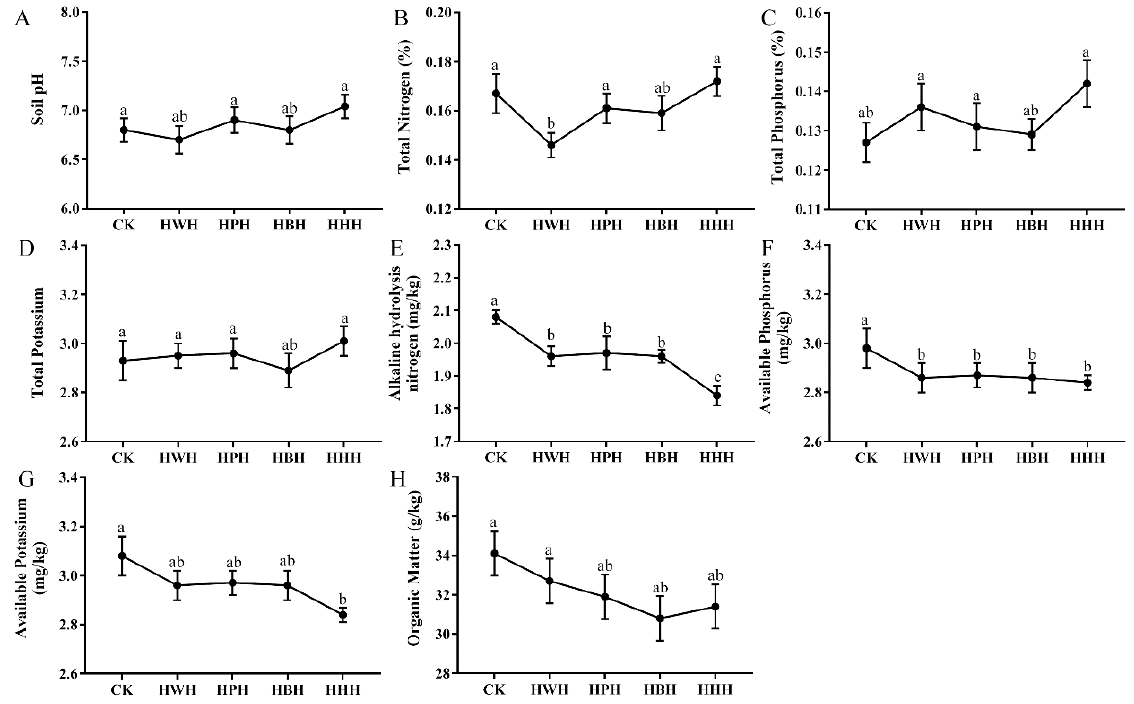
Figure 2. Effects of soil physicochemical properties. ( A ) Soil pH. ( B ) Total nitrogen for soil. ( C ) Total phosphorus for soil. ( D ) Total potassium for soil. ( E ) Alkaline hydrolysis nitrogen for soil. ( F ) Available phosphorus for soil. ( G ) Available potassium for soil. ( H ) Organic matter for soil. HWH, industrial hemp (year 1)—watermelon (year 2)—industrial hemp (year 3); HPH, industrial hemp (year 1)—potato (year 2)—industrial hemp (year 3); HBH, industrial hemp (year 1)—bean (year 2)—industrial hemp (year 3); HHH, industrial hemp in all three years; CK, no crop planted. Data are expressed as mean ± standard error ( n = 20). Letters on top of bars (a, b, or c) indicate the differences between groups according to Tukey’s test ( p <